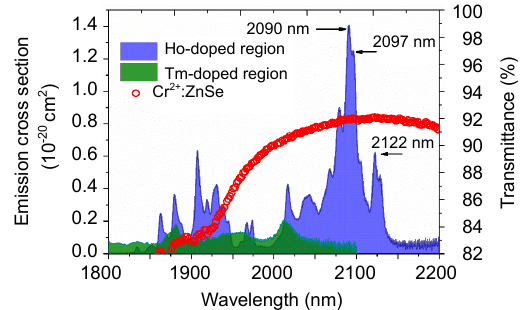
Fig. 3 | Emission cross section of the Tm-doped and Ho-doped regions and transmittance of the Cr:ZnSe SA.